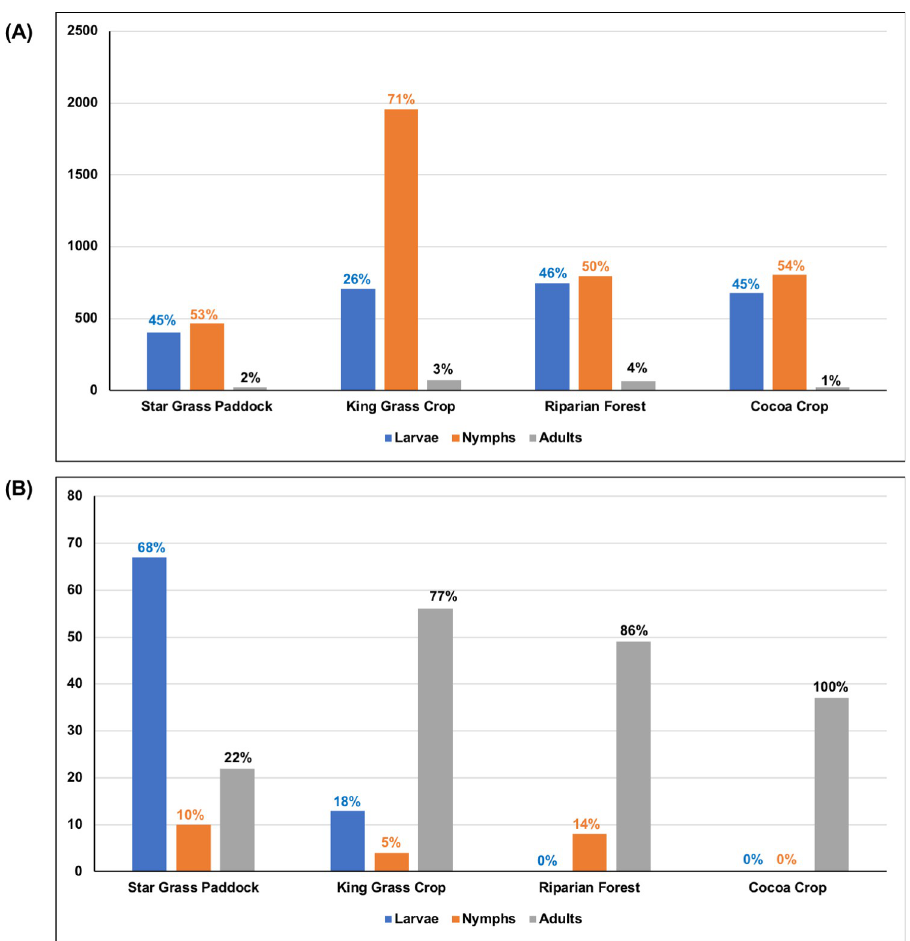
Fig 4. Abundance of A . mixtum in every sampled habitat according to the season in the Matepantano farm. (A). February of 2019 (dry season). (B). August of 2019 (wet season).